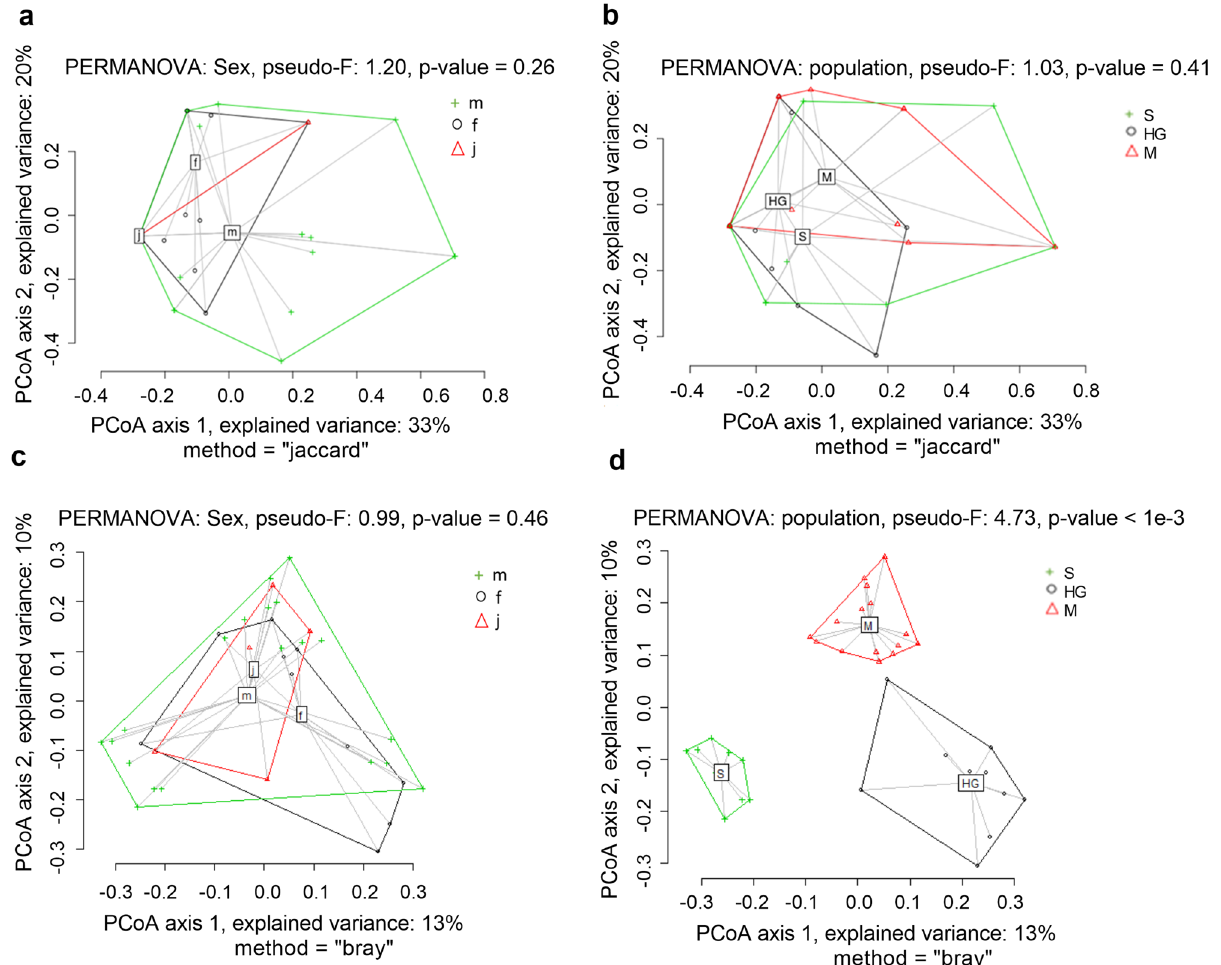
Figure 2. Principal coordinates analysis of Jaccard beta diversity matrices for diet of sexes ( a ) and locations ( b ). Principal coordinates analysis based on Bray–Curtis dissimilarity distance for microbiome composition of sexes ( c ) and locations ( d ). m = male, f = female, j = juvenile, HG = forest Heilig Geestgoed, M = forest Makegem and S = forest